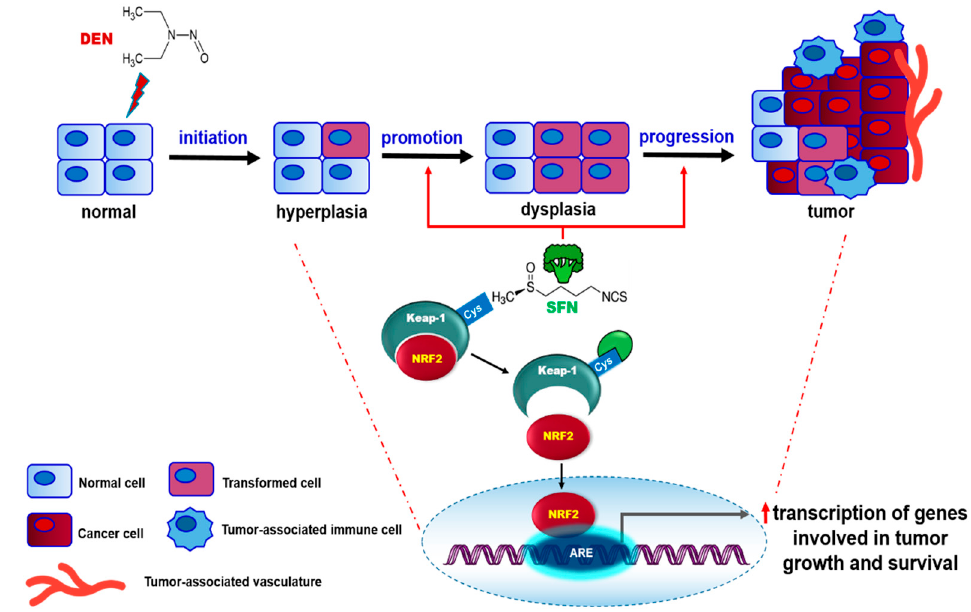
Figure 7. A proposed scheme illustrating the role of SFN in DEN-induced hepatocarcinogenesis.